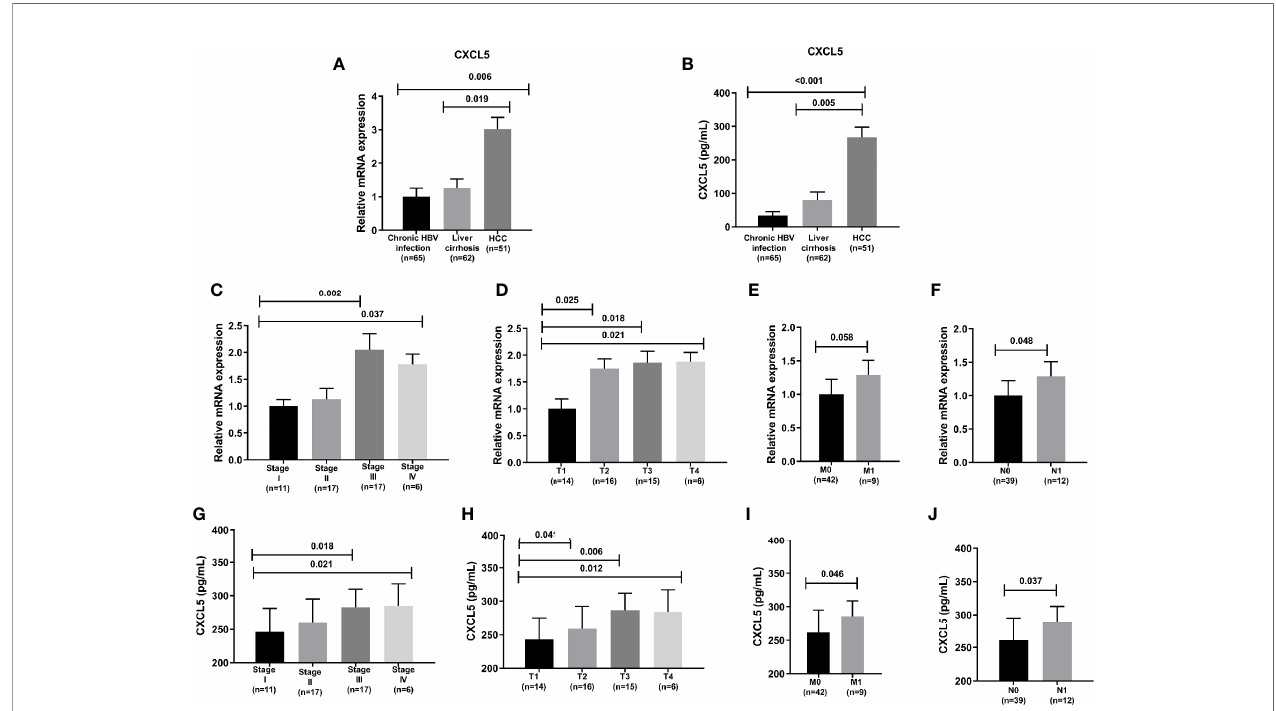
FIGURE 6 | The CXCL5 level and correlation with clinical characteristics. (A) The relative mRNA expression of CXCL5 in chronic HBV infection, liver cirrhosis, HCC; (B) The CXCL5 level by ELISA in chronic HBV infection, liver cirrhosis, HCC; (C – F) The correlation of CXCL5 mRNA expression with clinical characteristics; (G – J) The correlation of CXCL5 level by ELISA with clinical